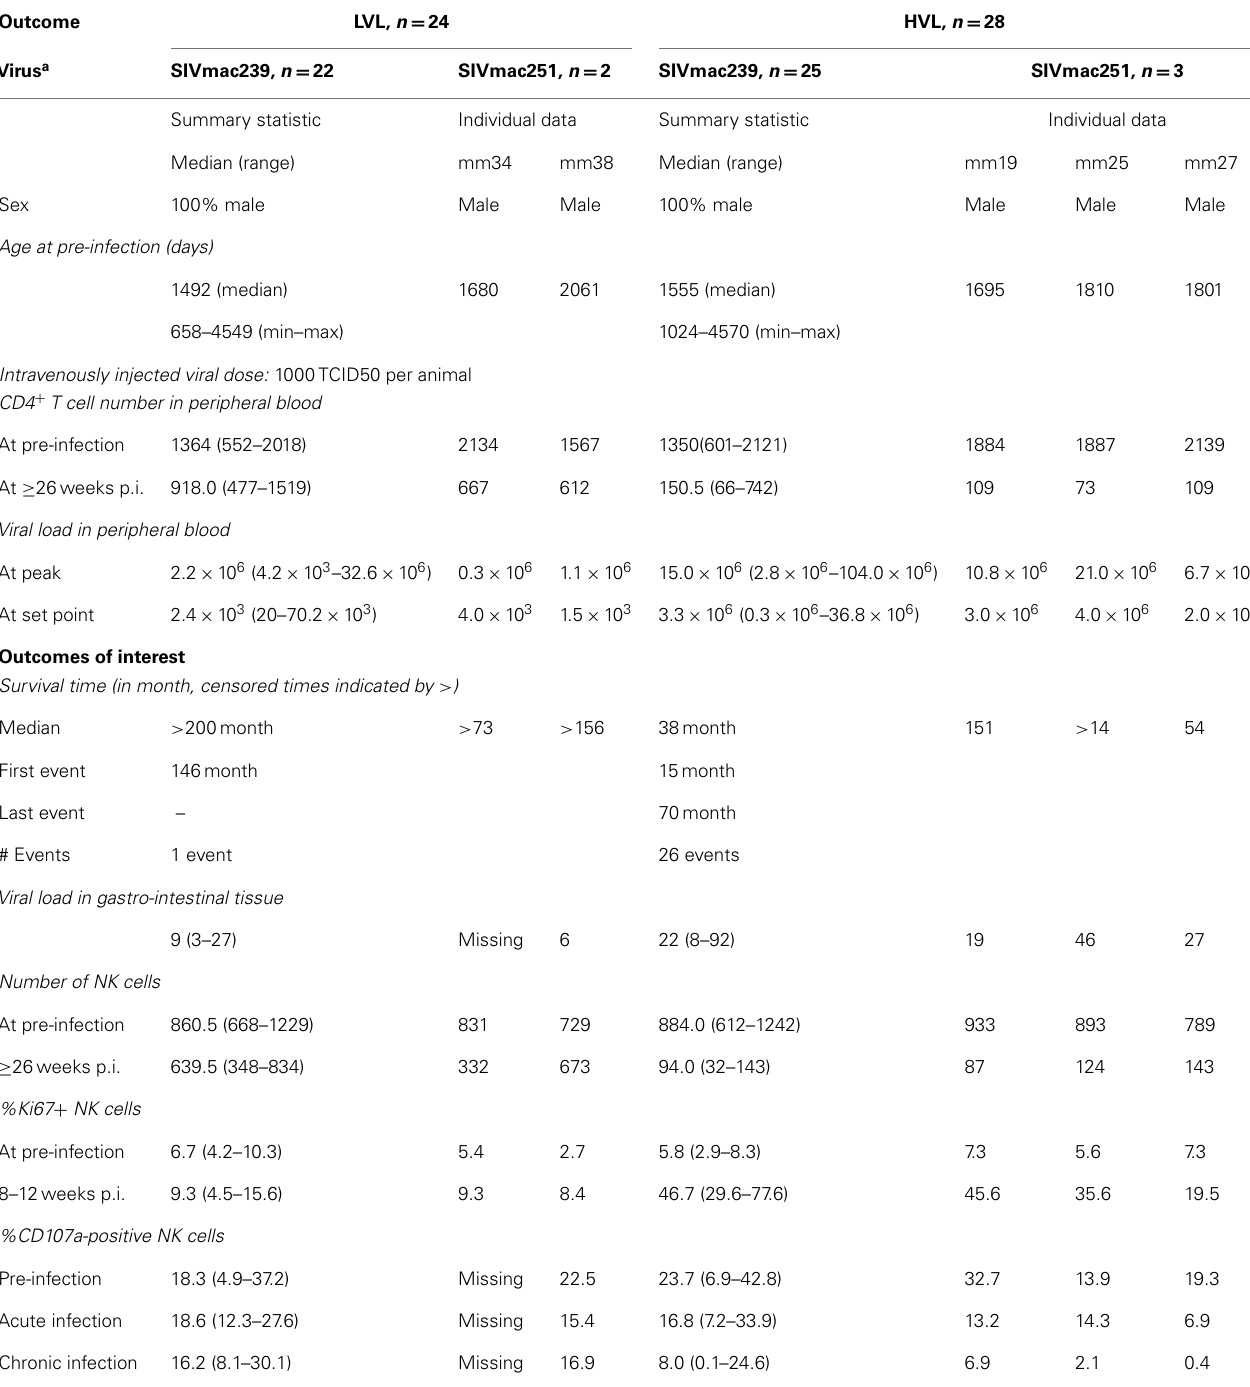
Table 1 | Overview of the macaque cohort ( n = 52)